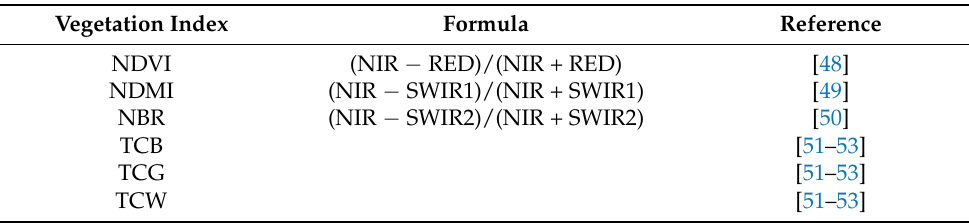
Table 1. Vegetation indexes calculated from the Landsat bands, where NIR is the near infrared band and SWIR1 and SWIR2 the first and second shortwave infrared bands,